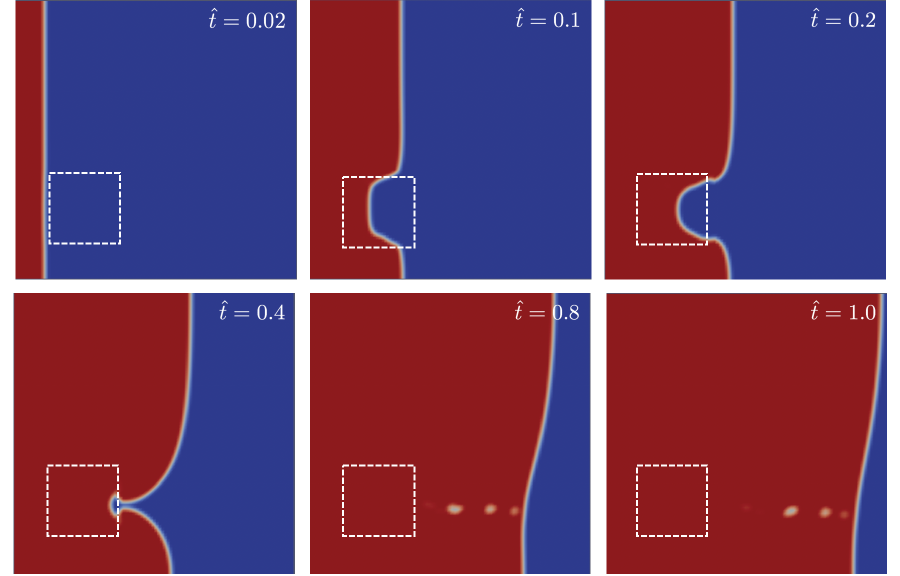
Figure 3. Snapshots of the flow progress through the mould for different non-dimensional times ˆ t = 0.02, 0.1, 0.2, 0.4, 0.8 and 1.0. The mould contains a square region of size 0.25 L centered at x and y 0 = 0.25 L with relative permeability of β = 0.1. Flow progress from left to right. Red and blue colours correspond to phase values of α = 0 and α = 1, respectively. For the sake of clarity, white dashed lines corresponding to the dissimilar material region were